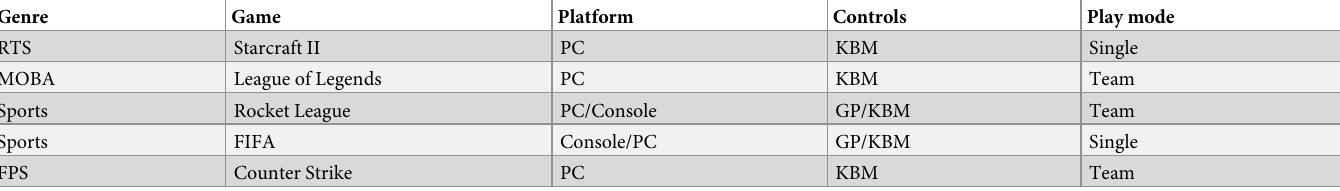
Table 5. Esports games selected for the